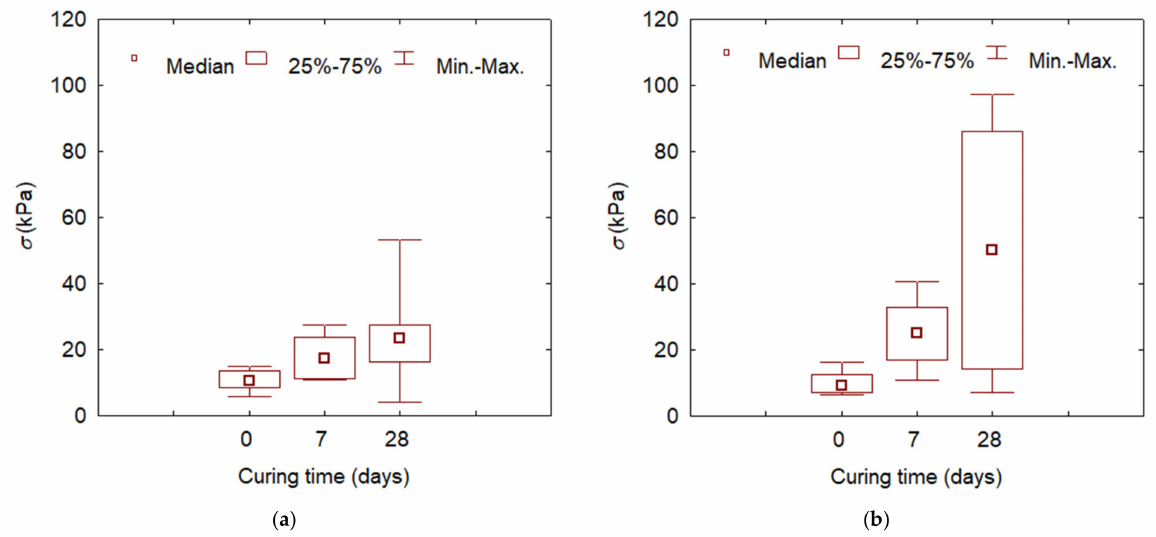
Figure 5. Ranges of variation of tensile strength values with time of curing: ( a ) direct method; ( b ) Brazilian method.